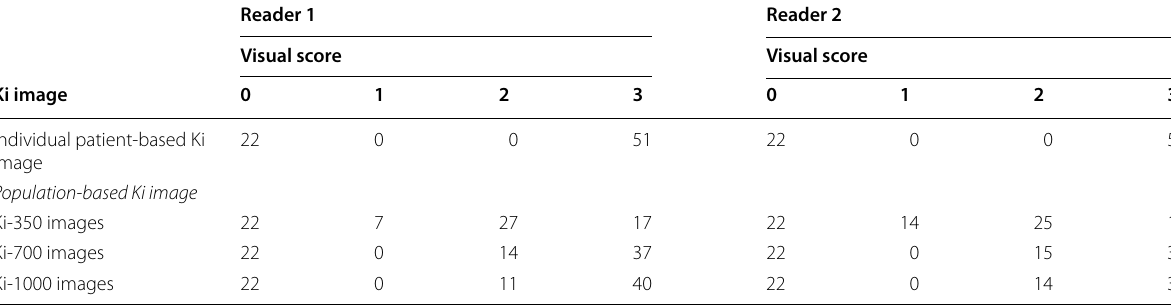
Table 1 Visual findings among the Ki images